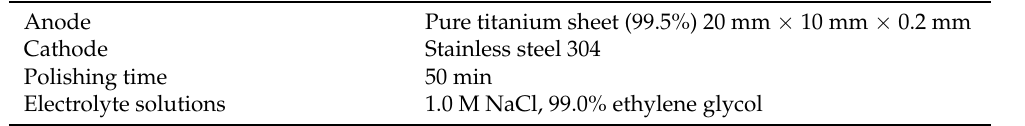
Table 5. The experimental parameters applied in this research.